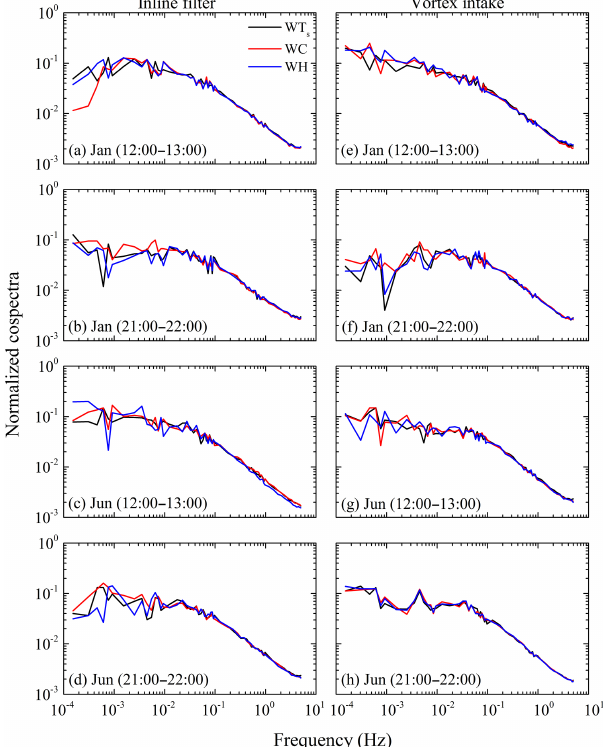
Figure 4. Normalized cospectra of the EC system (EC155) equipped with inline filter (a–d) and vortex intake (e–h) . WT s , WC and WH are cospectra of vertical wind velocity with sonic temperature, CO 2 and H 2 O. Cospectra are calculated from high- frequency data at 10Hz obtained from the Olympic Park. Data points in the figure are binned averages from means of a 1h period (12:00–13:00 and 21:00–22:00 Beijing Standard Time) for